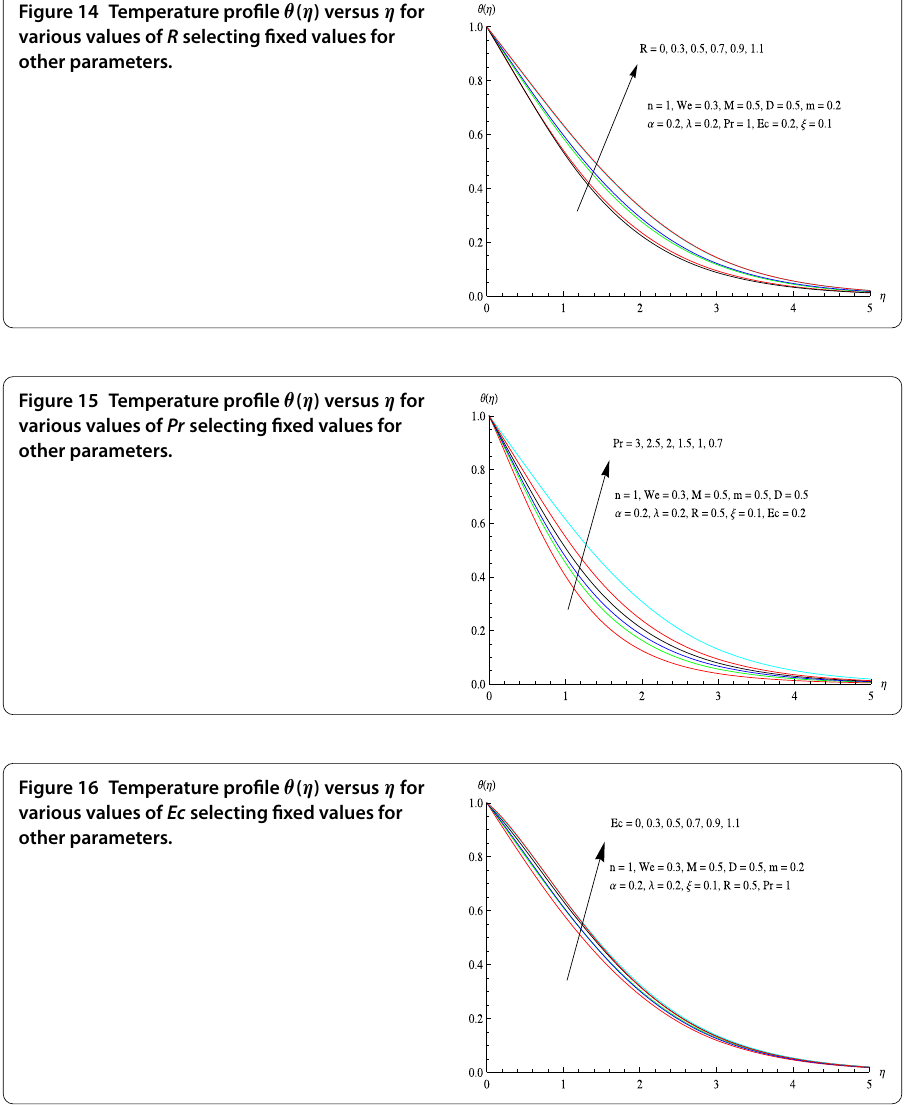
Figure 14 Temperature profile θ ( η ) versus η for various values of R selecting fixed values for other parameters.